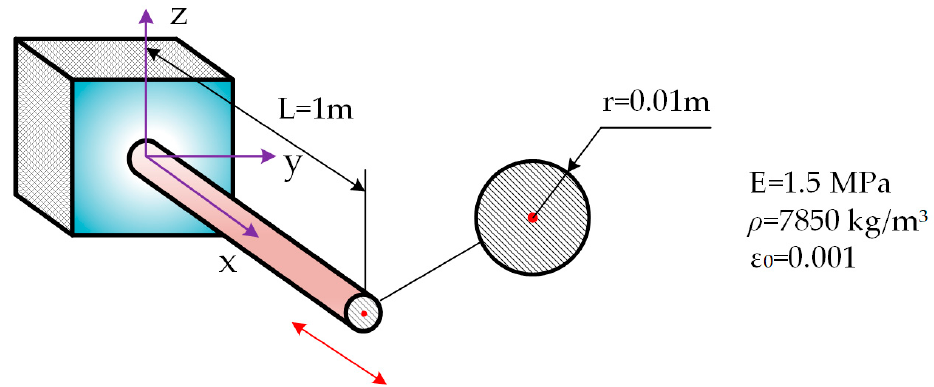
Figure 2. C antilever beam model. Figure 2. Cantilever beam model.